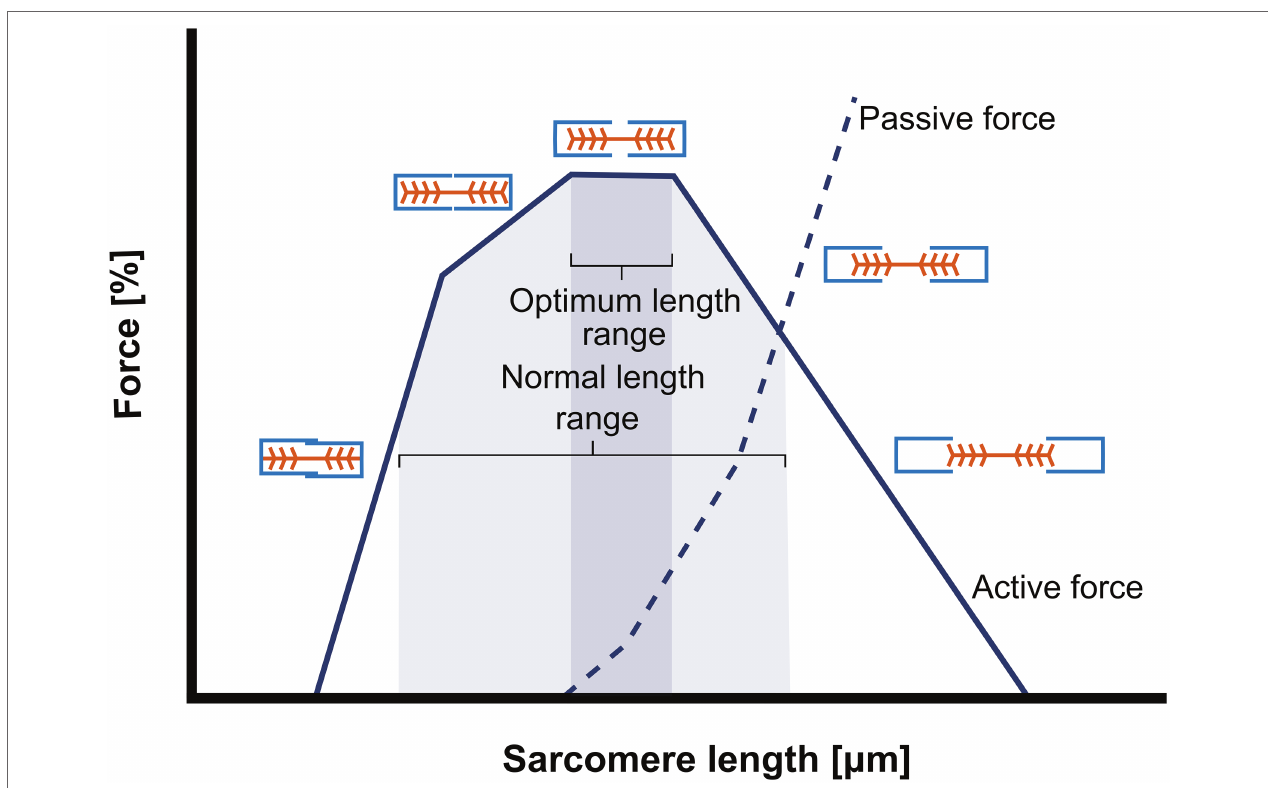
FIGURE 2 | Schematic representation of the sarcomere length-force curve. The figure illustrates the relationship between the amount of actin-myosin overlap and the isometric force generation. At very short sarcomere length force is low “owing to double interdigitation of actin filaments with both myosin and actin filaments from opposite sides of the sarcomere” (Lieber and Ward, 2011). In the ascending limb of the curve, active force (continuous line) of the single sarcomere increases with increasing sarcomeres length. When the sarcomere length is close to optimal (optimal actin-myosin overlap) and active force is maximal, passive force (---) starts to increase. Further increases in sarcomere length results in decreases in actin and myosin overlap, consequently active force decreases and passive force increases. The grey areas in the image represent the optimum length and the normal length range at which sarcomeres are usually functioning, both differ between species and